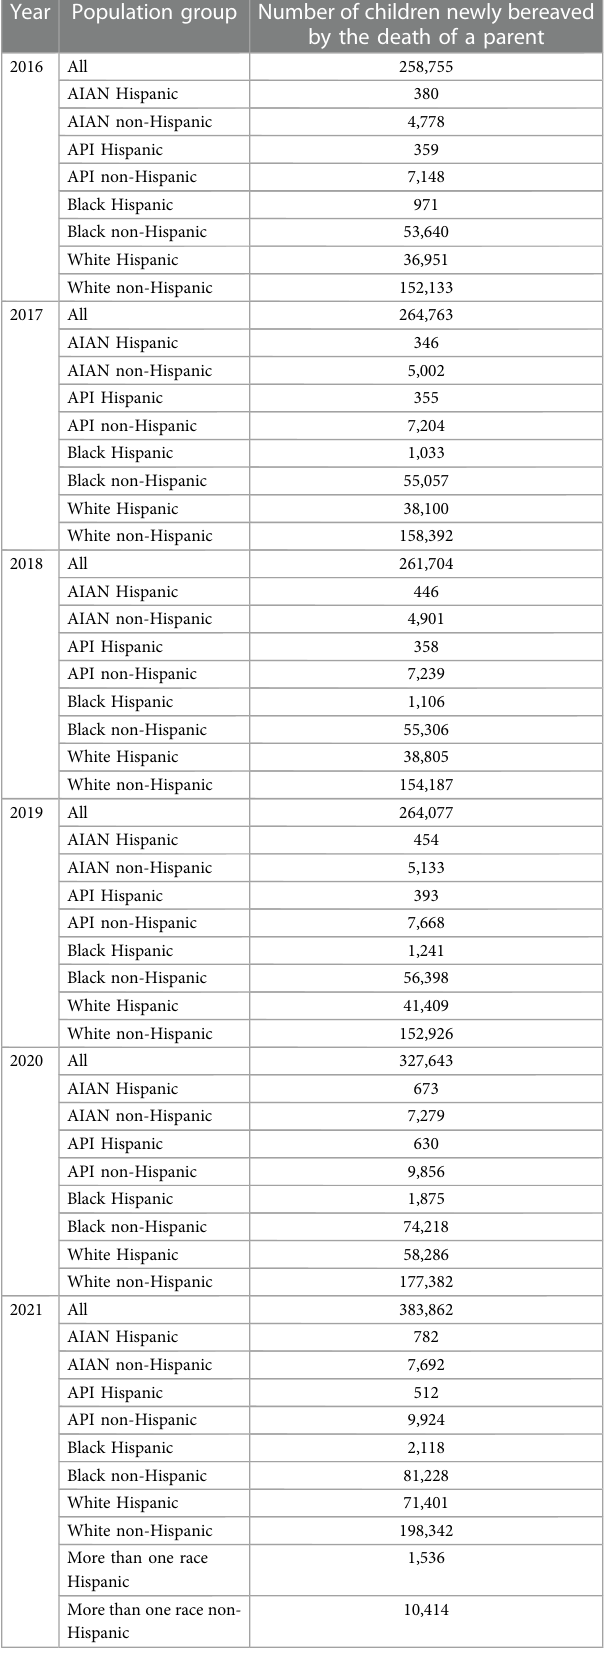
TABLE 3 CBEM parent death 1-year snapshot results 2016 – 2021 by child ’ s age and population subgroup. Year Population group Number of children newly bereaved by the death of a